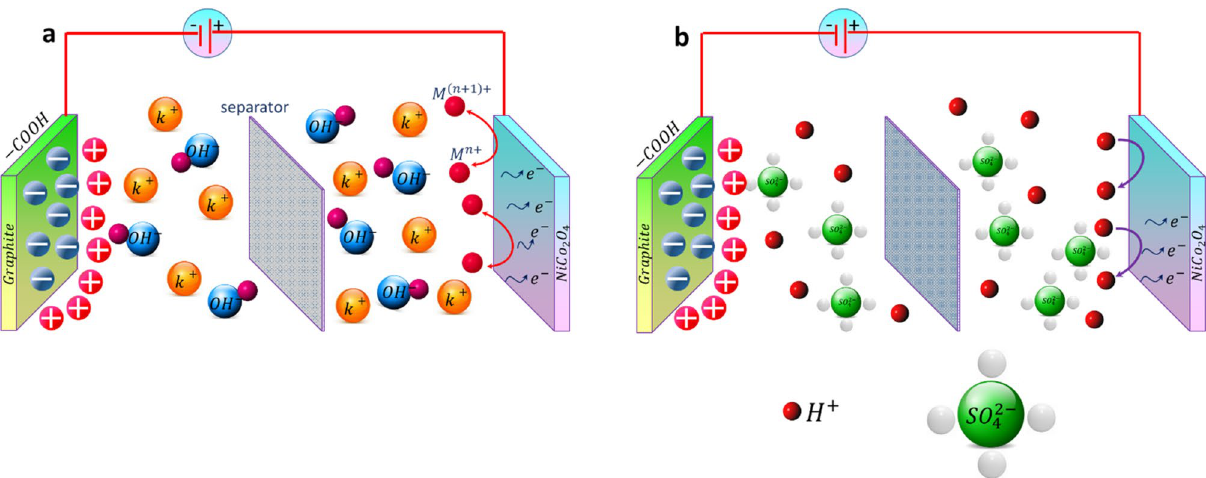
Fig. 9 Schematic diagram illustrates ionic diffusion and charge transfer in asymmetric supercapacitor of NiCo acidic H SO electrolyte aqueous 2 4